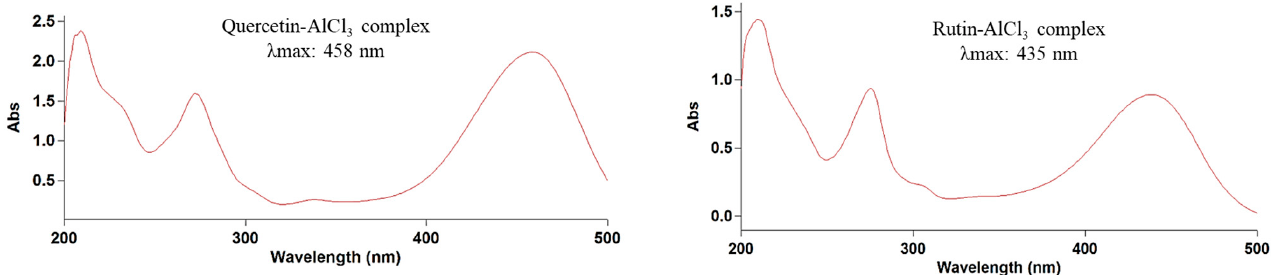
Figure 1. UV-Vis spectrum of quercetin and rutin standard solutions after complexing with AlCl 3 reagent.